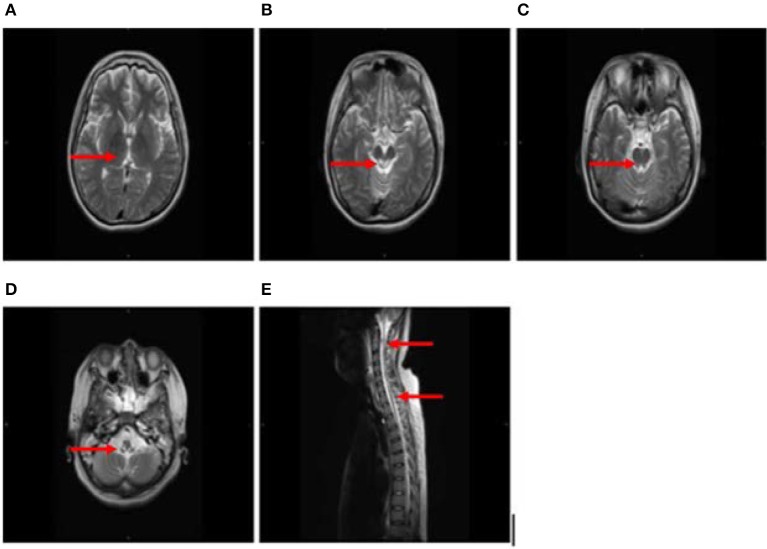
(A–E) T2-weighted MRI results at 8 months following hospitalization were similar to those obtained 1 month earlier (arrow in A–E).